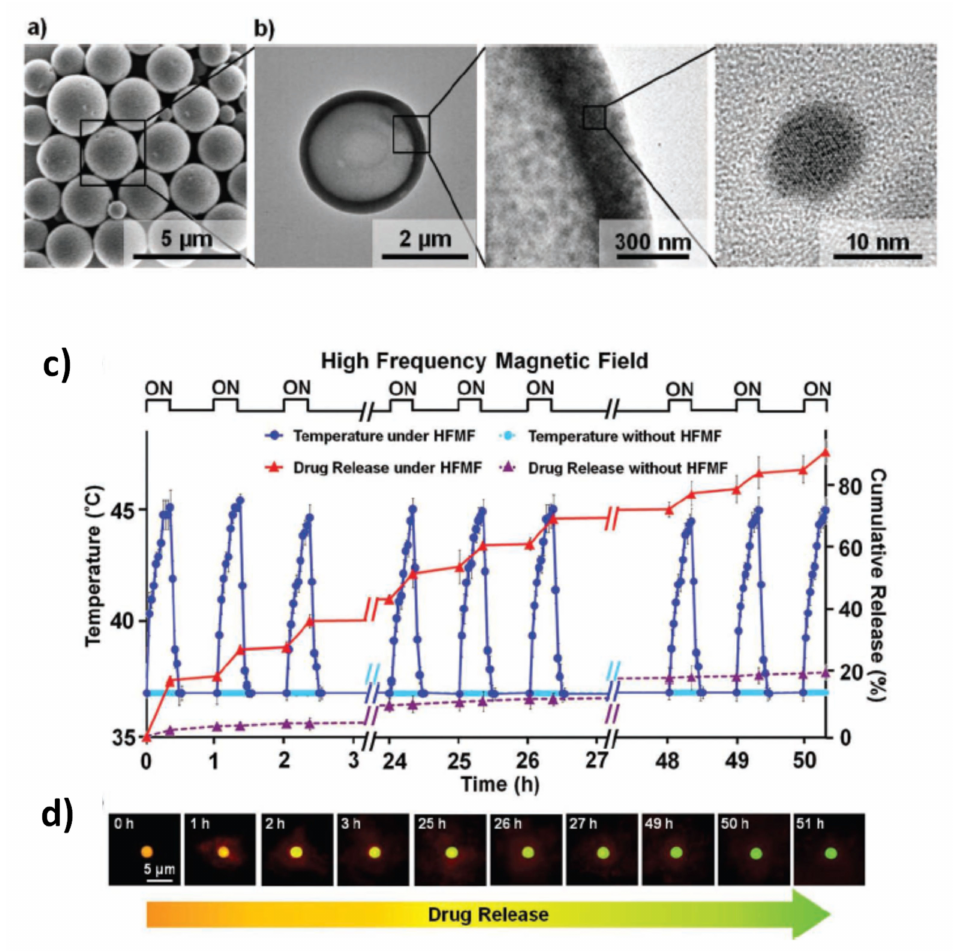
Figure 11. ( a ) SEM image of the PLGA hollow microspheres. ( b ) TEM images revealing the hollow structure of one microsphere and the single crystalline structure of the encapsulated iron oxide NPs. ( c ) Release profiles of DOX from the PLGA hollow microspheres, incubated in PBS, under AMF (2.5 kA/m and 50–100 kHz); the AMF was switched between “ON” and “OFF” modes. Their counterparts, not stimulated by AMF, were used as a control. ( d ) Fluorescence micrographs showing the changes in color of the hollow microspheres during the DOX release. Adapted with permission from Ref. [238], Copyright 2012 WILEY-VCH Verlag GmbH & Co. KGaA,